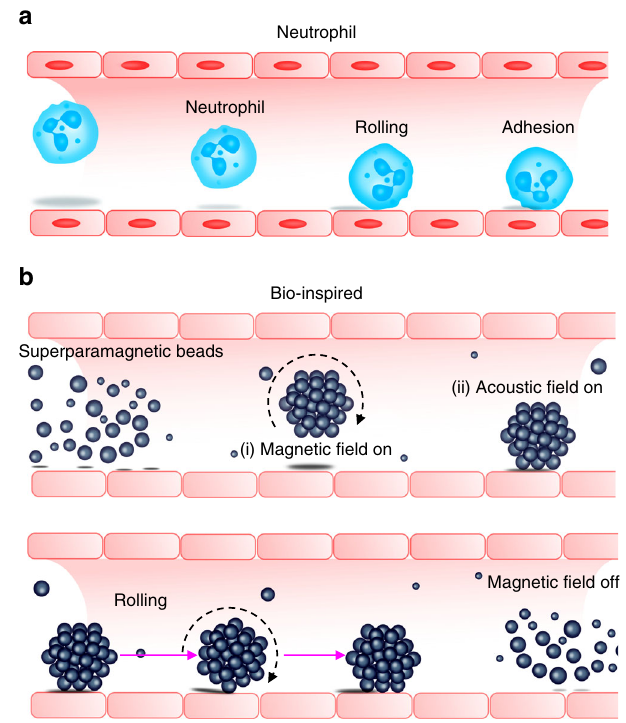
Fig. 1 Neutrophil-inspired propulsion based on acoustic and magnetic fi eld actuation. a Neutrophil rolls on vasculature before transmigrating into tissue. b Superparamagnetic particles aggregate due to dipole – dipole interaction in the presence of a magnetic fi eld (i). The aggregate migrates towards the wall due to the radiation force in an acoustic fi eld (ii). A rolling- type motion along the boundary is achieved by combining both fi elds.